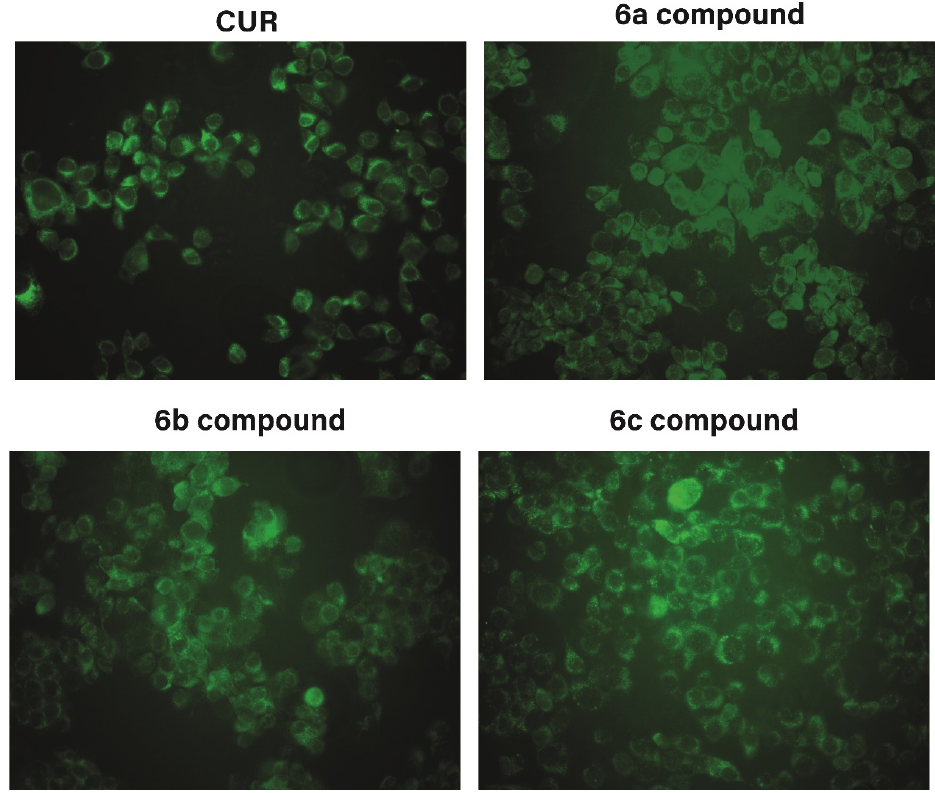
Figure 4 . Incorporation of curcumin ‐ derived compounds for the tumor cell line MCF7. The cells Figure 4. Incorporation of curcumin-derived compounds for the tumor cell line MCF7. The cells were were incubated with the different curcumin ‐ derived compounds 6a ‐ c with 20 μ M for 1 h with cur ‐ incubated with the different curcumin-derived compounds 6a - c with 20 µ M for 1 h with curcumin as cumin as the control. the control.